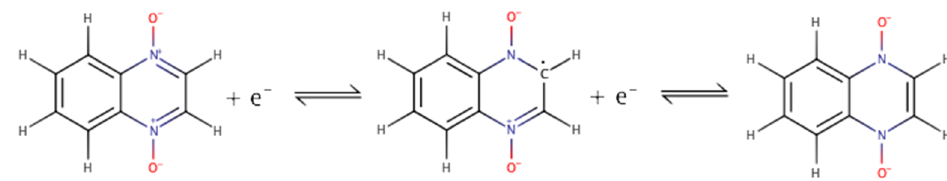
Table 1. Structures of the 3-aryl-quinoxaline-2-carbonitrile 1,4-di-N-oxide derivatives